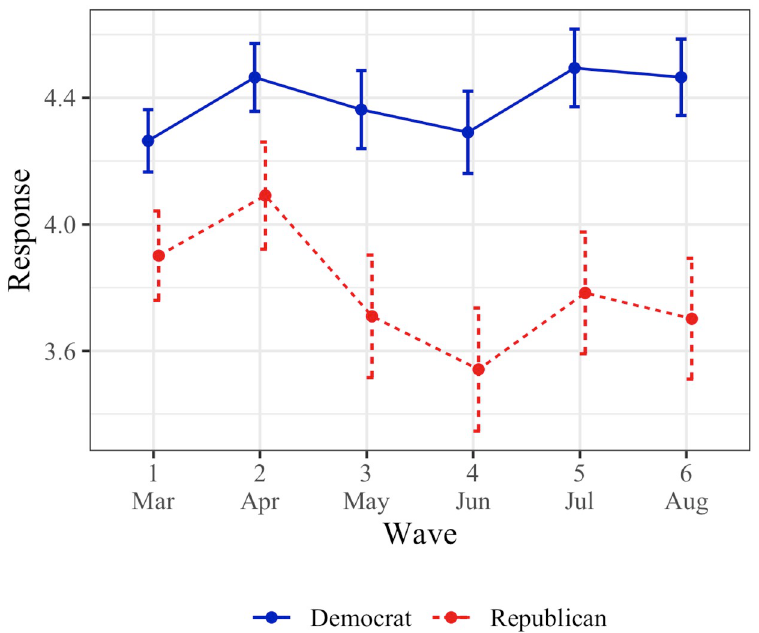
Fig 2. Perceived threat of COVID-19 by political affiliation (March–August 2020). Points represent means, and error bars represent 95% confidence intervals. All scale responses range from 1 to 7.